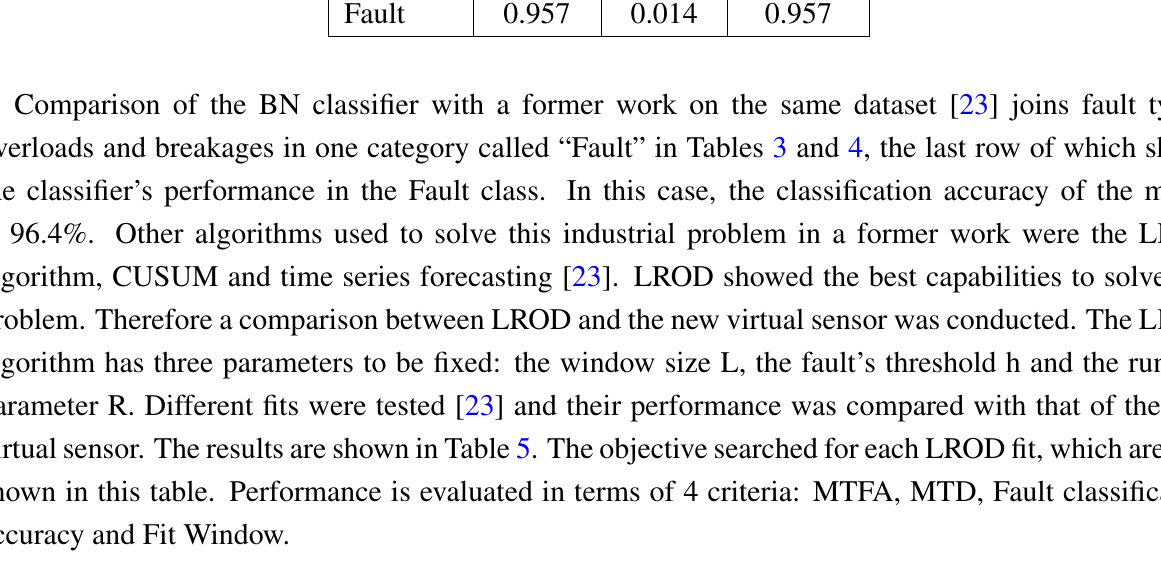
Table 5. Comparison of the performance of LROD algorithm and classifier ensembles for imbalanced